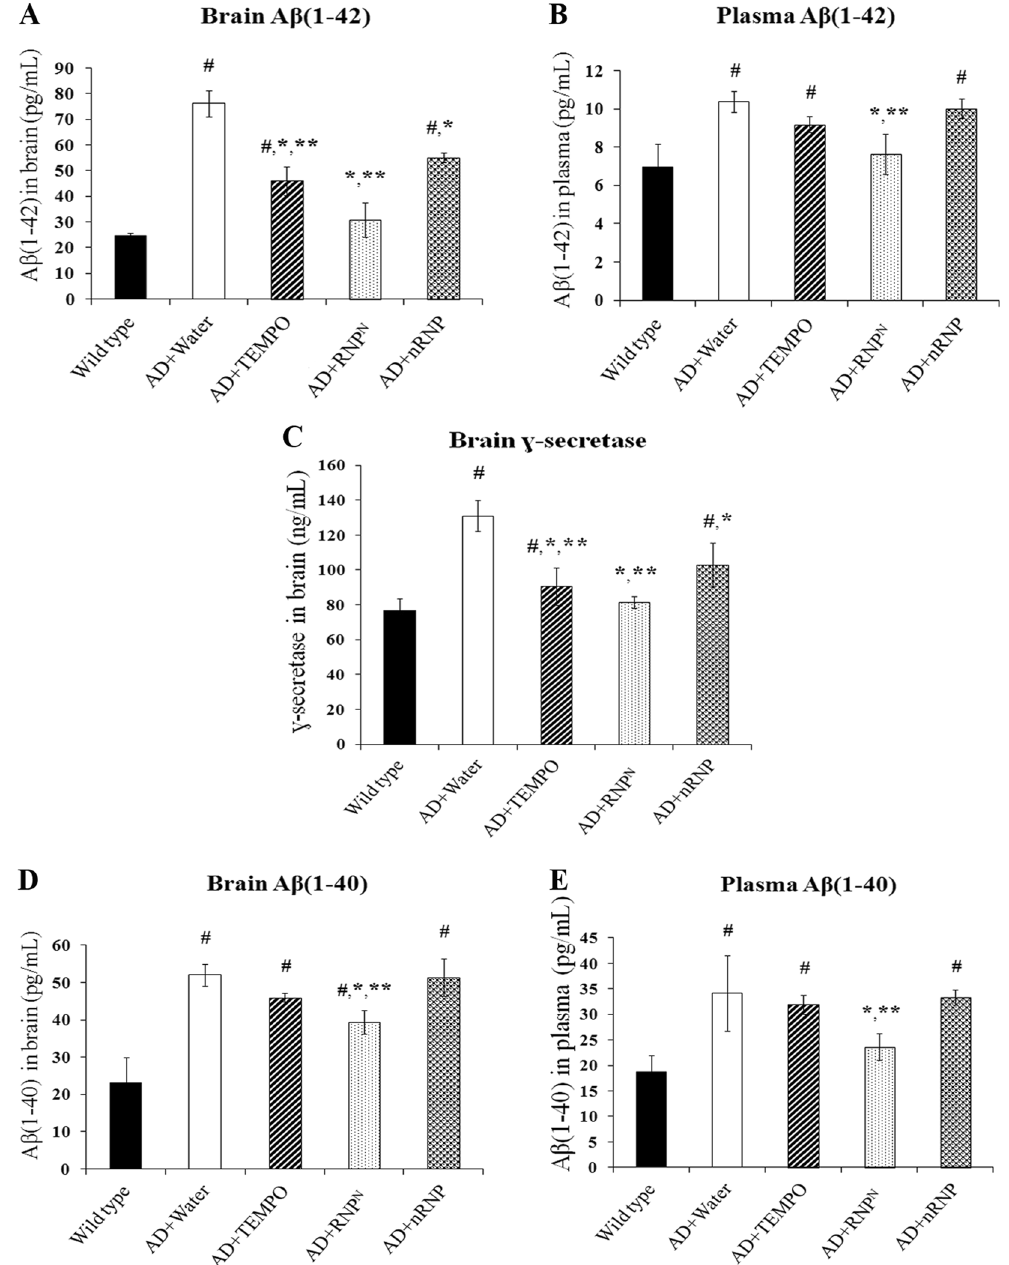
Figure 4. The effect of ad libitum drinking of RNP N on A β (1-42) in the brain ( A ), the plasma ( B ), γ -secretase in the brain ( C ) and A β (1-40) in the brain ( D ), A β (1-40) in the plasma ( E ) of mice. Data were expressed as mean ± SEM, # vs. wild-type group, p < 0.05; * vs. AD mice treated with water, p < 0.05; ** vs. AD mice treated with nRNP, p < 0.05, n = 5